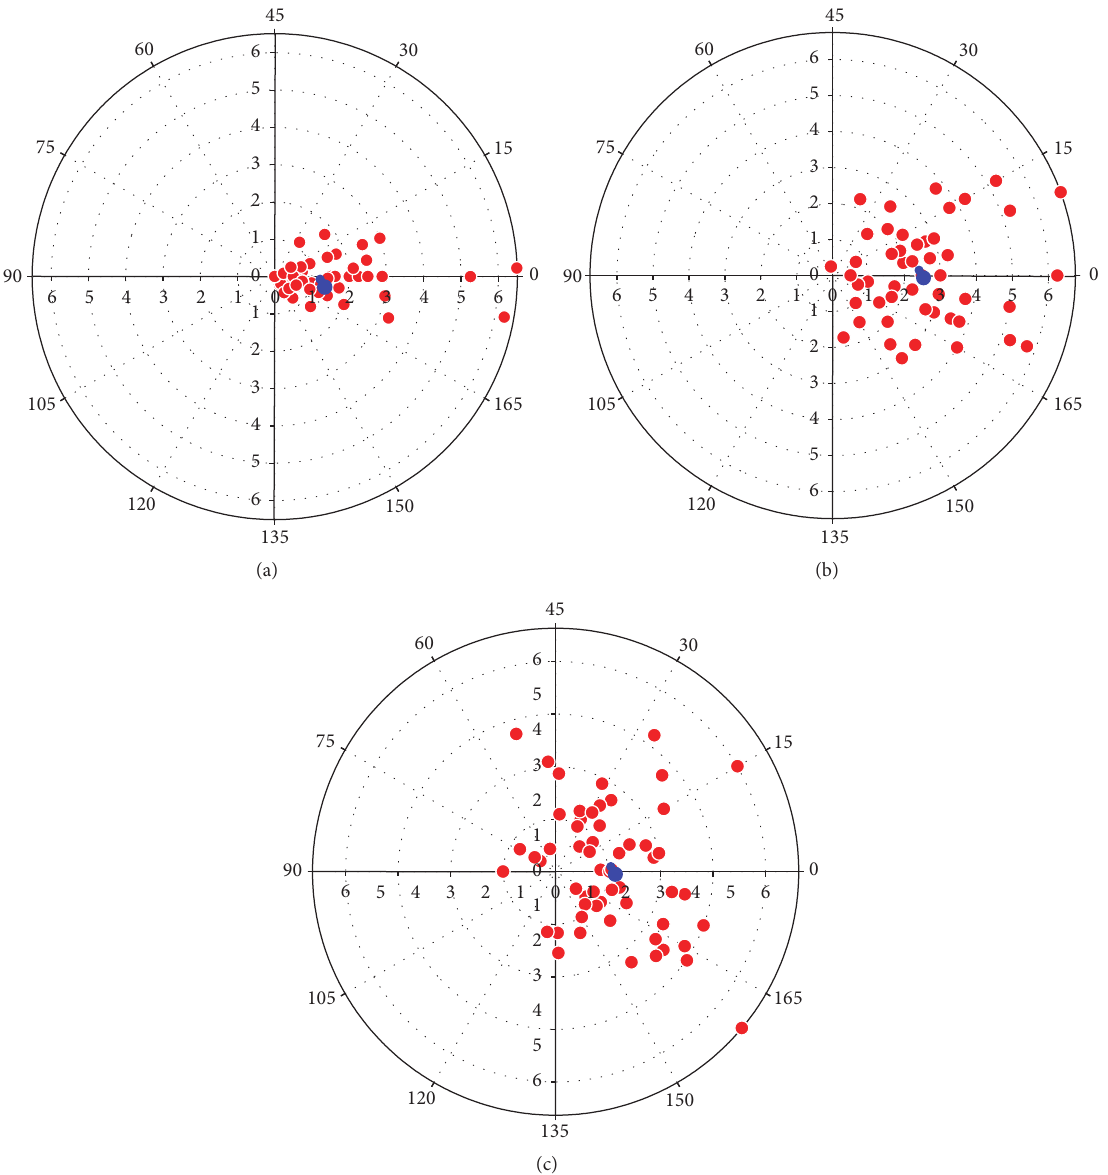
Figure 2: Double-angle plots of preoperative, 12-week postoperative, and surgically induced astigmatism. Coordinates of the preoperative astigmatism (a) are more clustered around its centroid value than the 12-week postoperative astigmatism (b) and the SIA (c). The coordinates are shown in red and the centroid value is shown in